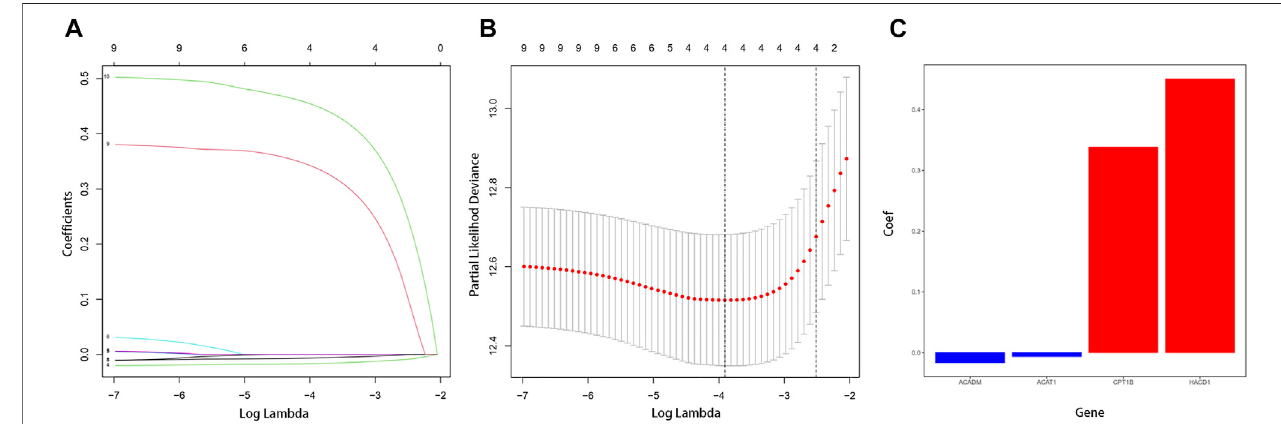
FIGURE1| Establishmentoffattyacidmetabolismrisksignature. (A) LASSOcoef fi cientpro fi lesforthe10differentiallyexpressed genes. (B) Optimalparameter( λ ) was chosen by cross-validation. (C) Coef fi cient values of the four fatty acid metabolism – related genes screened by the LASSO